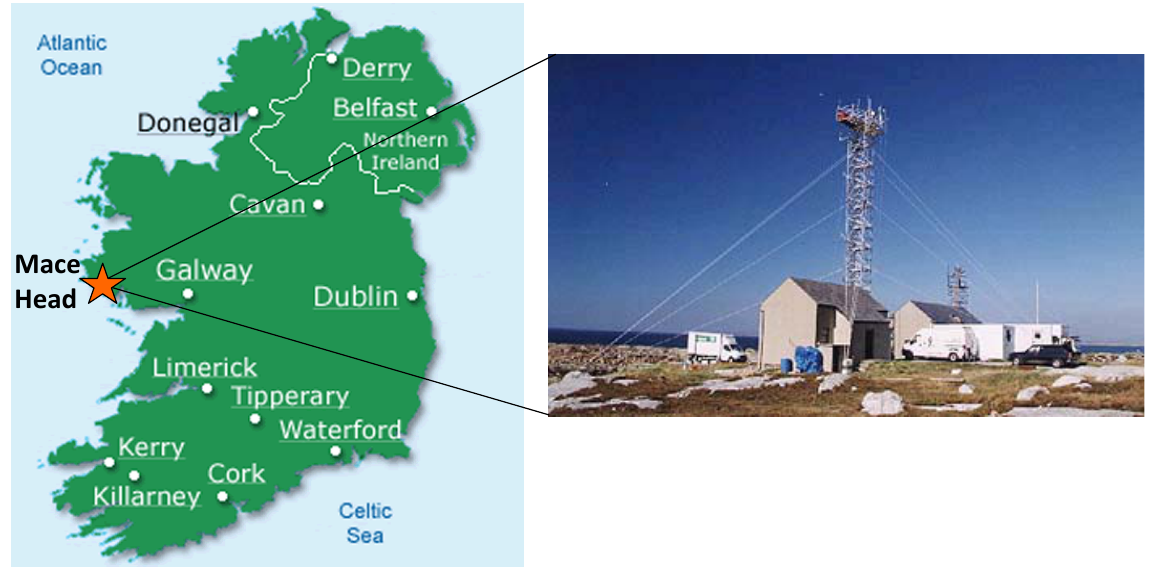
Fig. 1. Location of the Mace Head research station on the west coast of